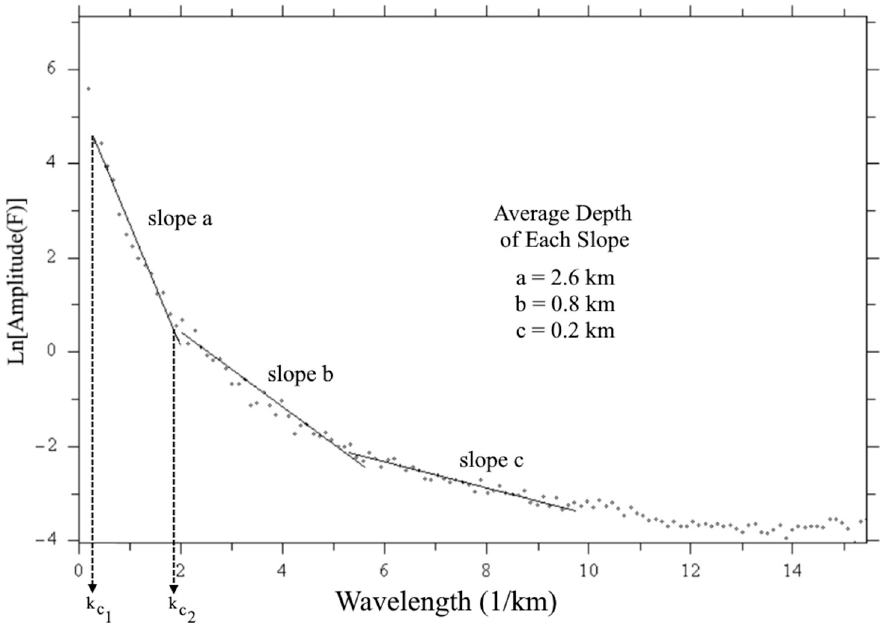
Figure 4. The radially averaged amplitude spectrum of the Bouguer anomalies. The line segments with three different slopes (a, b, and c) were fitted in each radial wavenumber section. The critical wave numbers of the line segment giving the basement rock (2.6 km) are marked as k1 and k2. The depths from the a and b segments correspond to the mean depth of 0.8 km of engineering bedrock and mean depth of 0.2 km soft sedimentary layer, respectively.